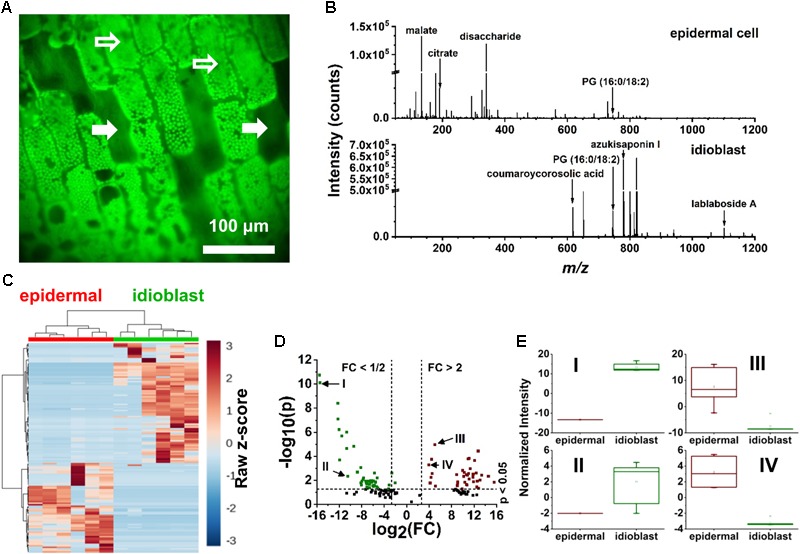
Localization of idioblast and spectral variance within the E. densa single epidermal and idioblast cells from a whole leaf tissue. (A) An optical image from the CTM microscope with the blue illumination conditions. Epidermal cells (indicated by open arrows) contain chloroplasts, whereas idioblasts lack chloroplast and are non-fluorescent (close arrows). (B) A typical negative ion mode mass spectrum from (top) an epidermal cell and (bottom) idioblast cell, indicating the metabolite differences. (C) A heat map consisting of (n = 6 each) epidermal and idioblast single cells to illustrate the clustering of spectral features from the mass spectra, where each column is a spectrum and each row is an m/z value. (D) Volcano plot of significantly different spectral features from (green) idioblasts and (red) epidermal cells. For example, (I) azukisaponin I and (II) coumaroylcorosolic acid were found to be more abundant in idioblasts, whereas (III) citrate and (IV) malate are at higher level in epidermal cells. The threshold values of a fold change >2 and the p-value <0.05 based on the Student’s t-test were only considered. (E) Four significant species that were identified from the volcano plot, (I) azukisaponin I, (II) coumaroylcorosolic acid, (III) citrate, and (IV) malate.